Question: In one sentence, what is this figure communicating?
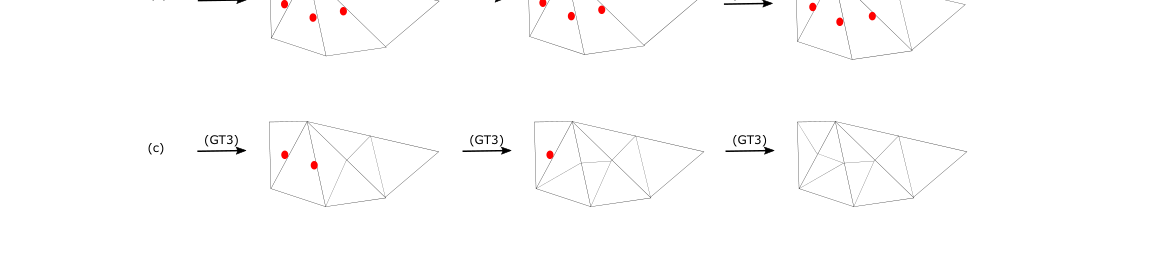
Answer: Rivara algorithm of refinement, step by step.